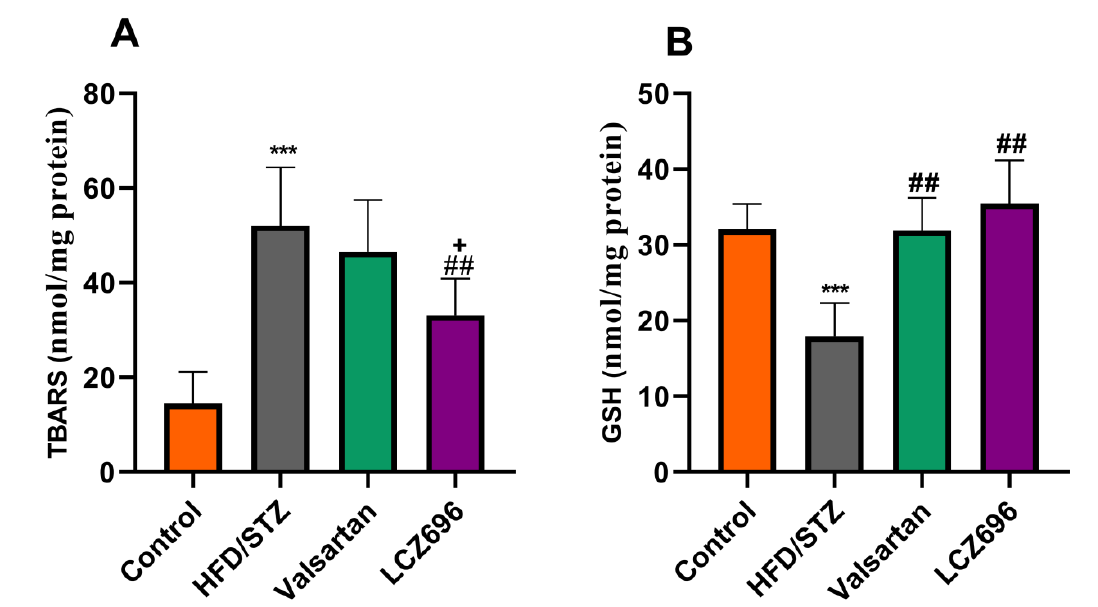
Figure 3. The effects of LCZ696 and valsartan administration on renal oxidative stress markers in HFD/STZ-induced diabetic rats, including thiobarbituric acid reaction substances (TBARs) ( A ) and glutathione (GSH) ( B ). The data are expressed as the mean ± SEM, n = 6, *** p < 0.001 versus control; ## p < 0.01 versus HFD/STZ; + p < 0.05 versus valsartan.